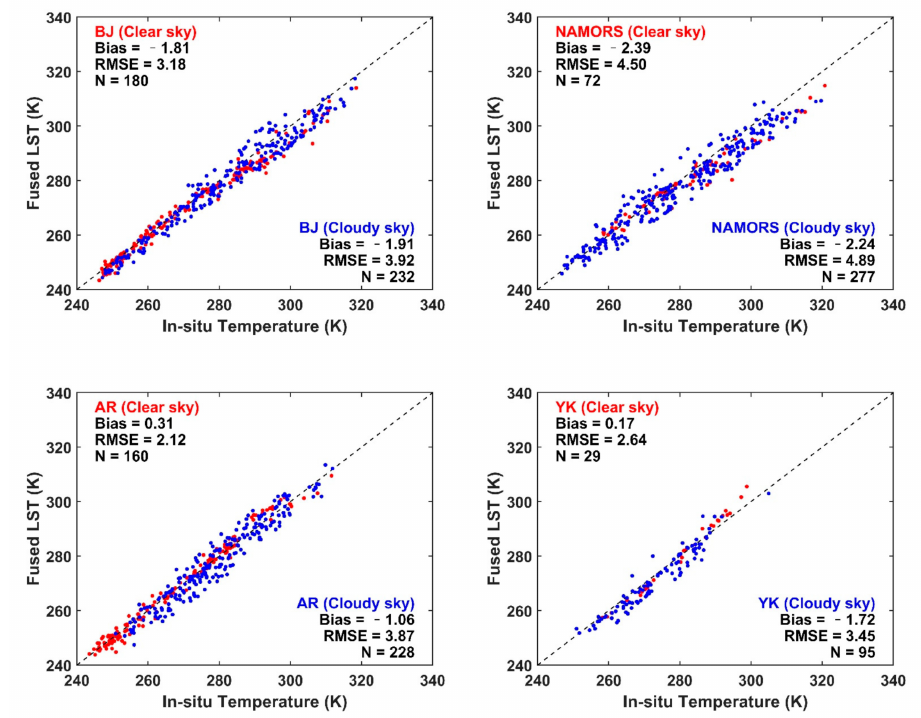
Figure 10. The scatter plots of the in situ temperature and the fused LST at each